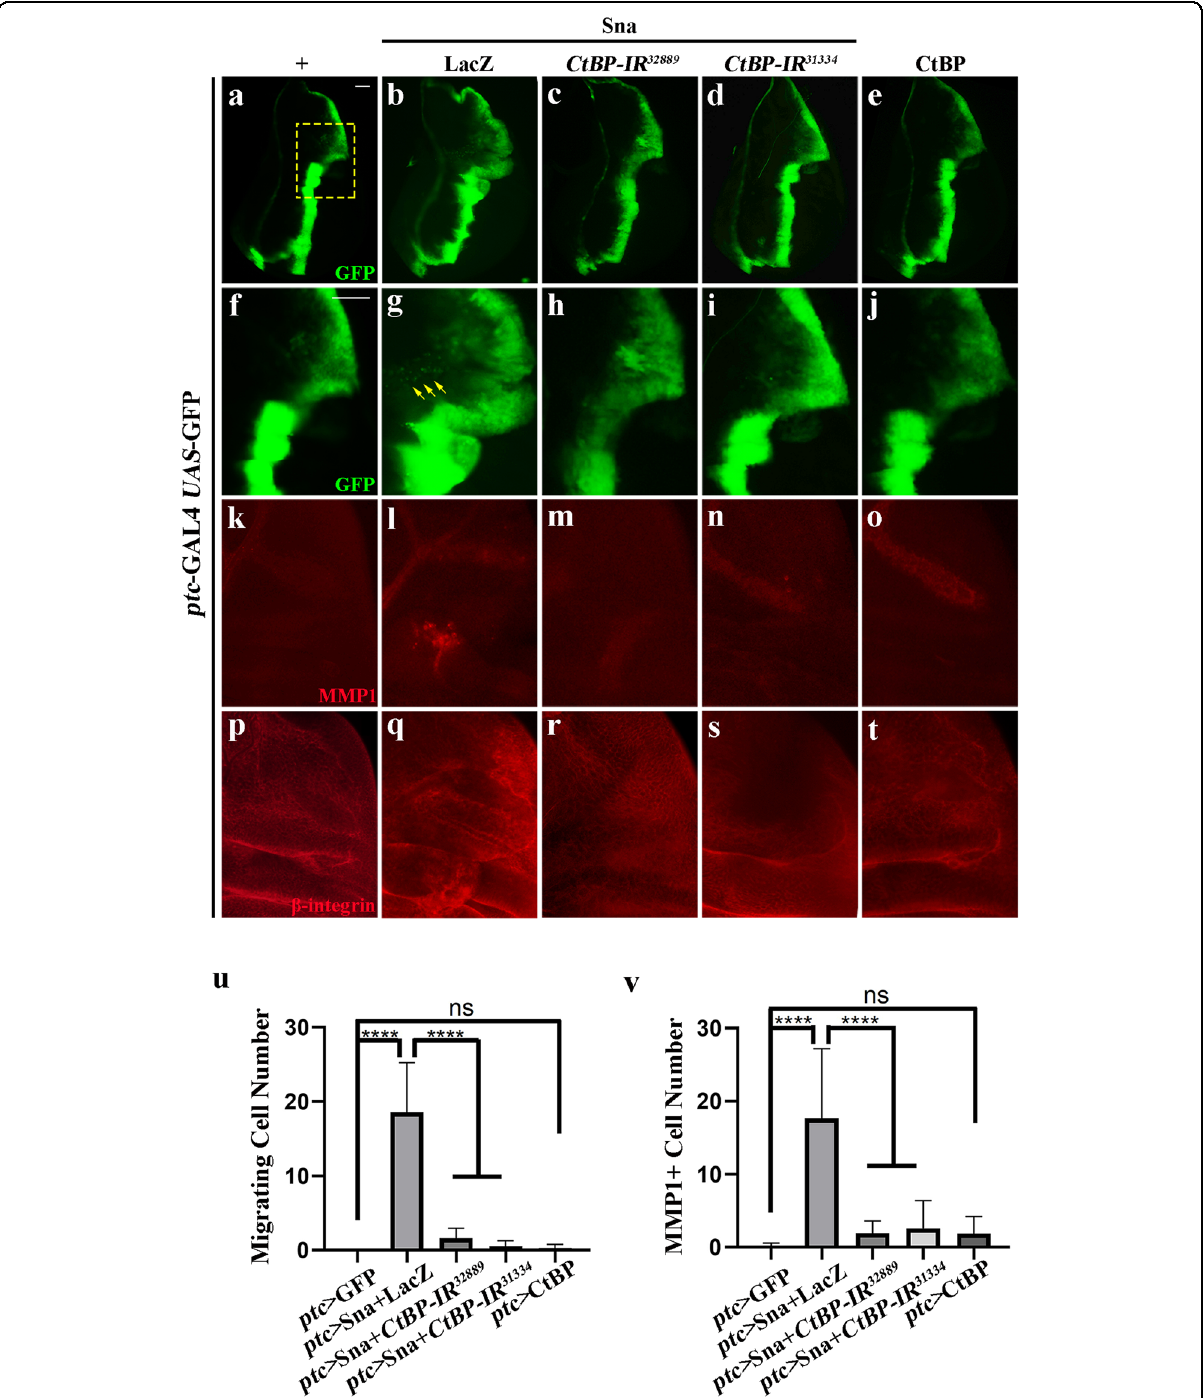
Fig. 5 CtBP is indispensable for Sna-induced invasive cell migration. ( a – t ) Fluorescence micrographs of 3 rd -instar larval wing disks are shown. Anterior is to the left and dorsal up. The individual channels detecting only GFP (green, a – e and f – j ), only MMP1 (red, k – o ), and only β -integrin signal (red, p – t ). f – j , k – o and p – t are high magni fi cation of the yellow-dotted boxed areas in a – e . ptc -GAL4 UAS -GFP is the control ( a , f , k and p ). Ectopic expression of Sna-induced cell migration ( g , yellow arrows indicate the migrated cells), MMP1 upregulation ( l ), and β -integrin accumulation ( q ) was impeded by RNAi-mediated inactivation of CtBP ( h , i , m , n , r and s ). While expression of CtBP alone did not produce visible defects during larval stage ( e , j , o and t ). Statistical analysis of migrating cell number ( u ) and MMP1 + cell number ( v ), error bars indicate standard deviation. One-way ANOVA with Bonferroni multiple-comparison test was used to compute P -values, **** P < 0.0001; ns, no signi fi cant difference. See the electronic supplementary material for detailed genotypes. Scale bar: 40 µm ( a – t